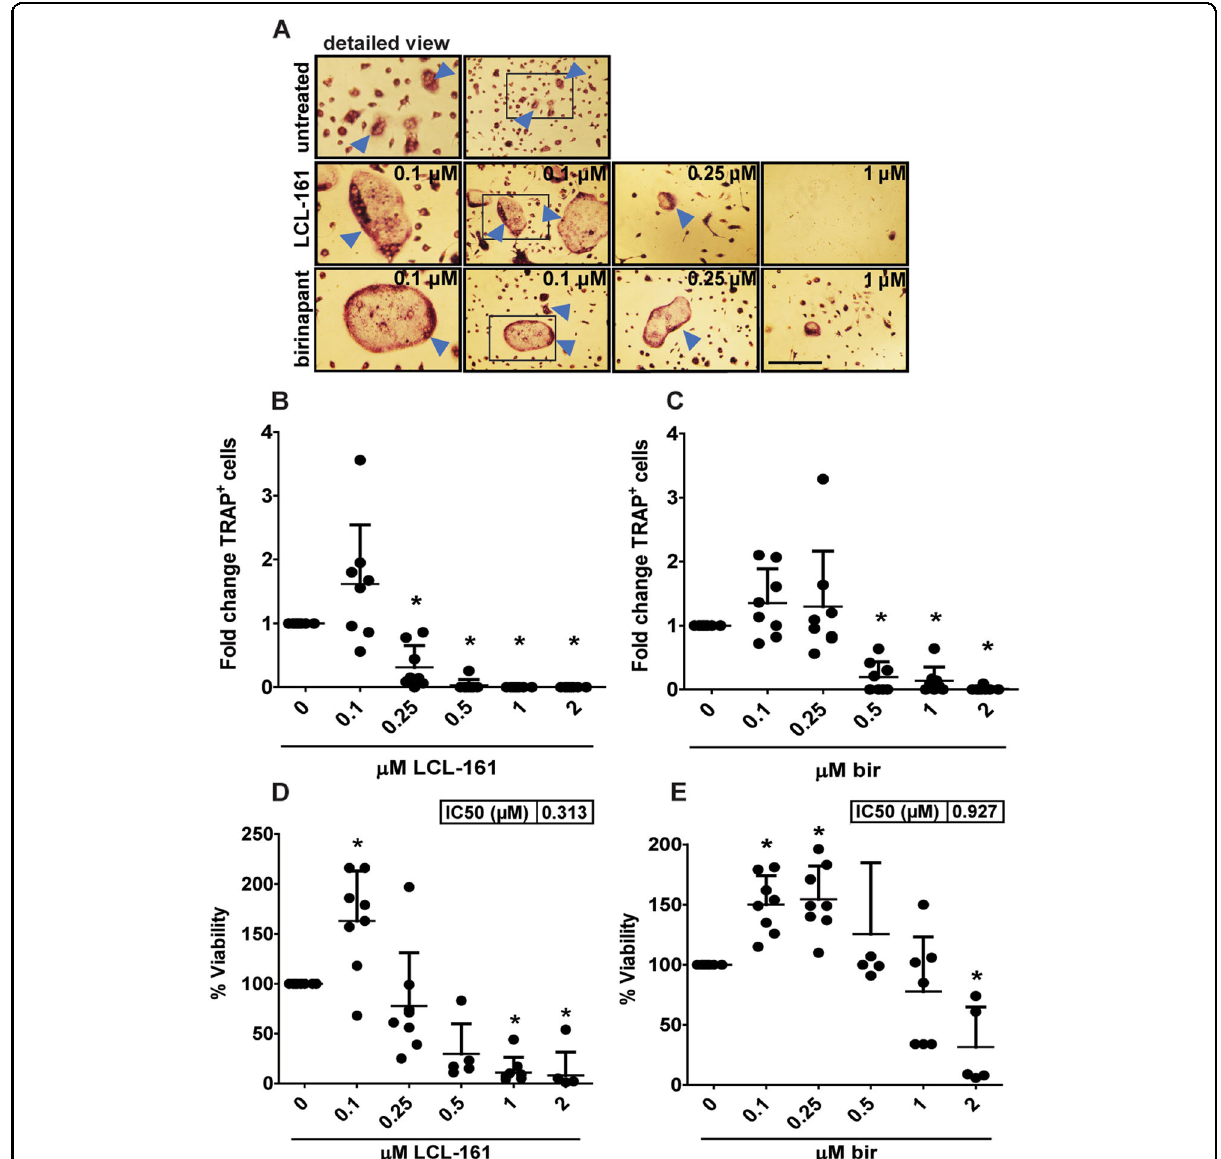
Fig. 4 SM induces dose-dependent effects on mouse osteoclasts. C57BL/6 mouse BMDMs were differentiated to OC and treated with LCL-161 and birinapant at indicated concentrations throughout OC differentiation ( A – E ). Representative phase-contrast images of TRAP-stained mouse OCs, with arrowheads indicating multinuclear TRAP + cells counted as OC. Frame in second column indicates cutout for detailed view. Bar is 150 μ M (A). Fold change of TRAP + OCs after birinapant and LCL-161 treatment ( B , C ), shown for 8 donors. The viability of OC after differentiation SM was measured by the Cell Titer Proliferation Assay ( D , E ). Individual mice, mean, and SD are shown. Asterisk denotes statistical signi fi cance as compared to the untreated control ( p < 0.05, One-way